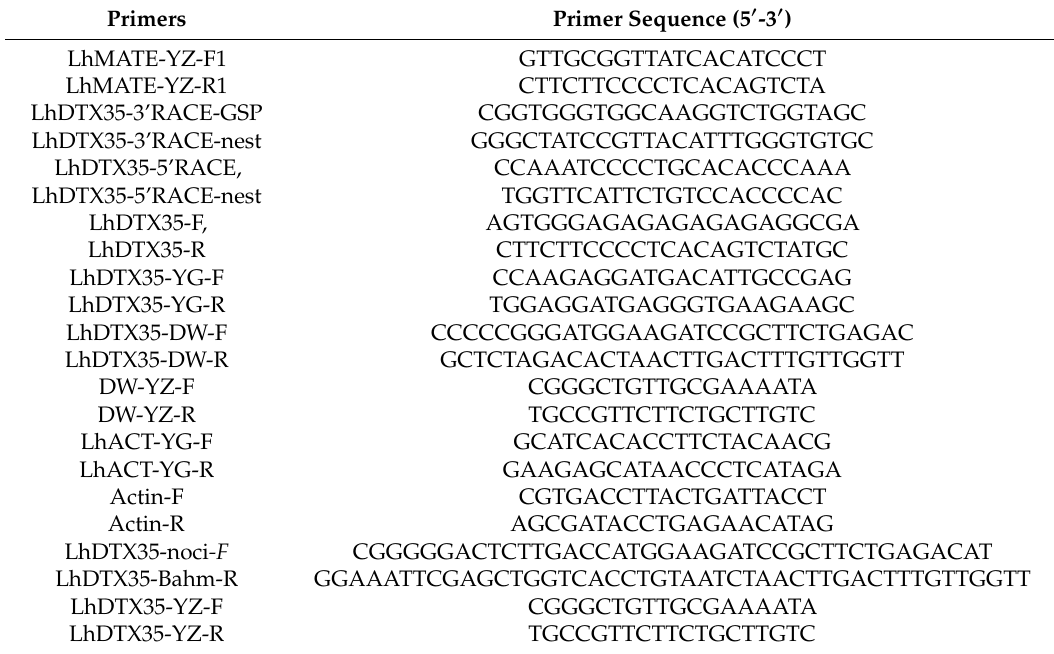
Table 1. All primers used in this study. Primers Primer Sequence (5 (cid:48) -3 (cid:48)